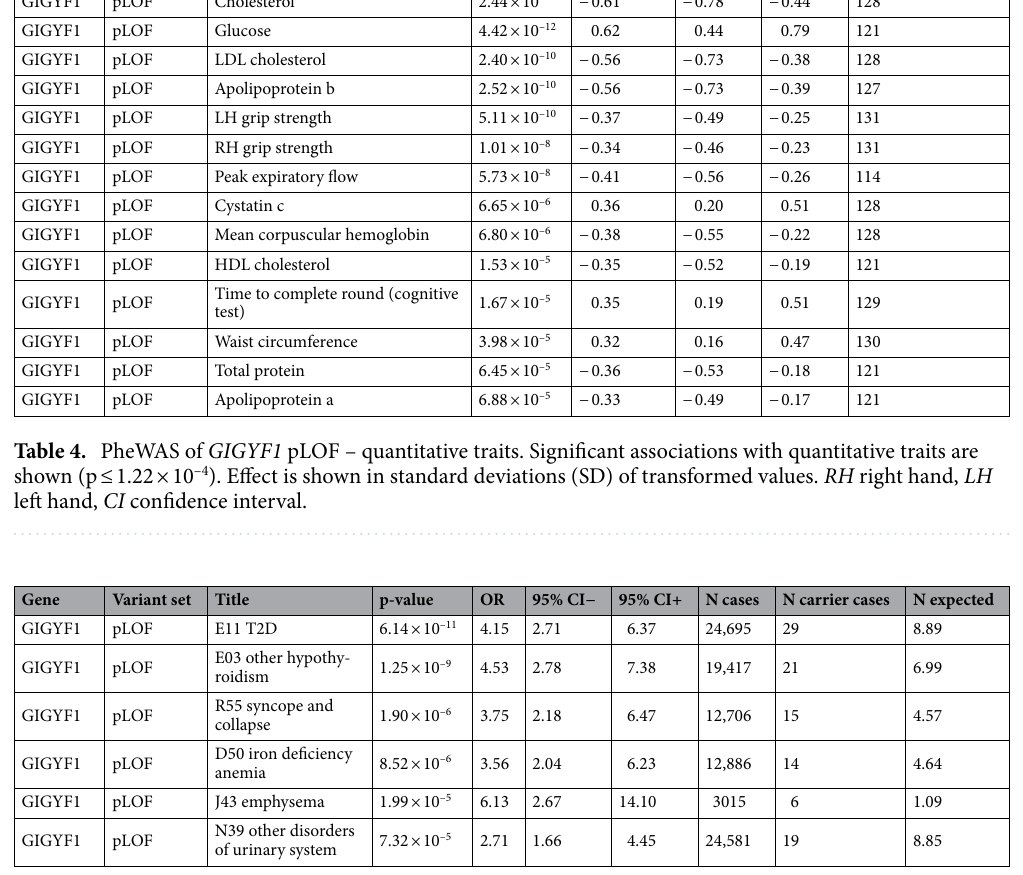
Table 5. PheWAS of GIGYF1 pLOF—ICD10-coded diagnoses. Significant associations with ICD10-coded diagnoses are shown (p ≤ 1.22 × 10 –4 ). OR odds ratio, CI confidence interval.